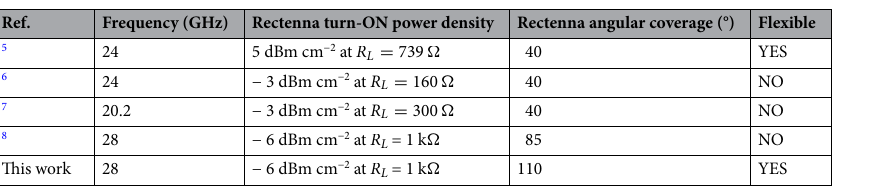
Table 1. Performance comparison.